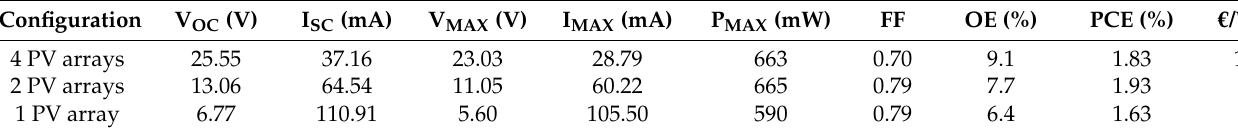
Table 1. Electrical performance of unshaded LSC panels under a GNI equal to 630 W/m 2.